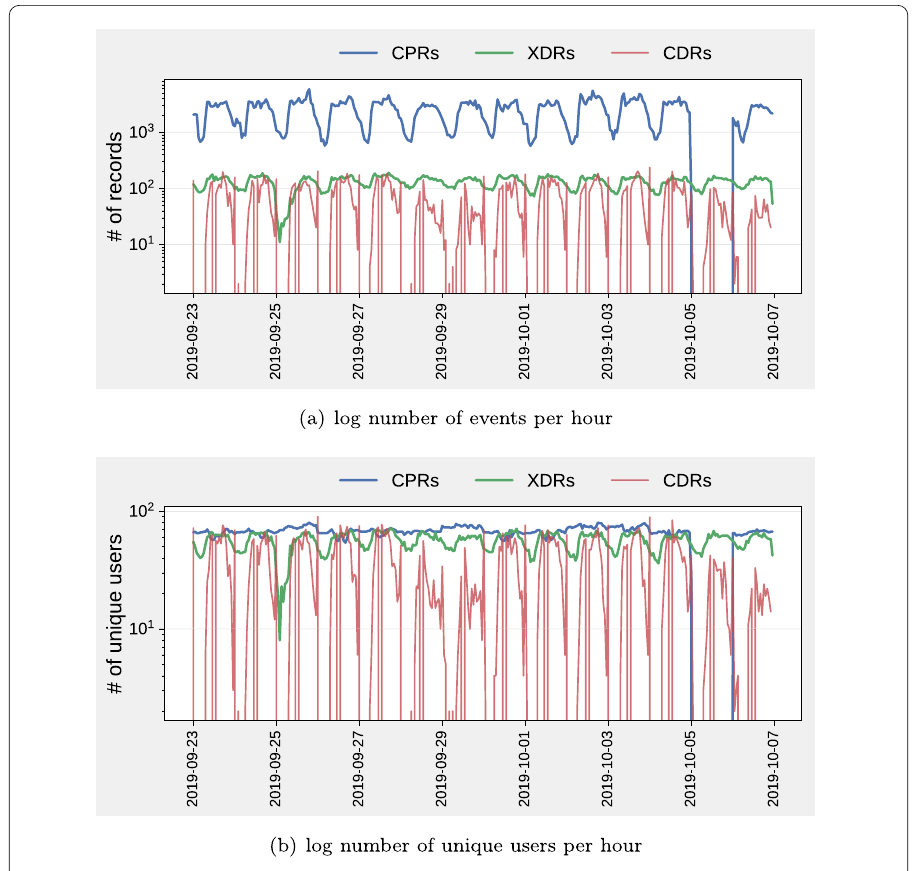
Figure 3 A comparison of the number of ( a ) records and ( b ) unique users for CDRs, XDRs and CPRs, for 14 days (except Oct 5 for CPRs, for which there was no data